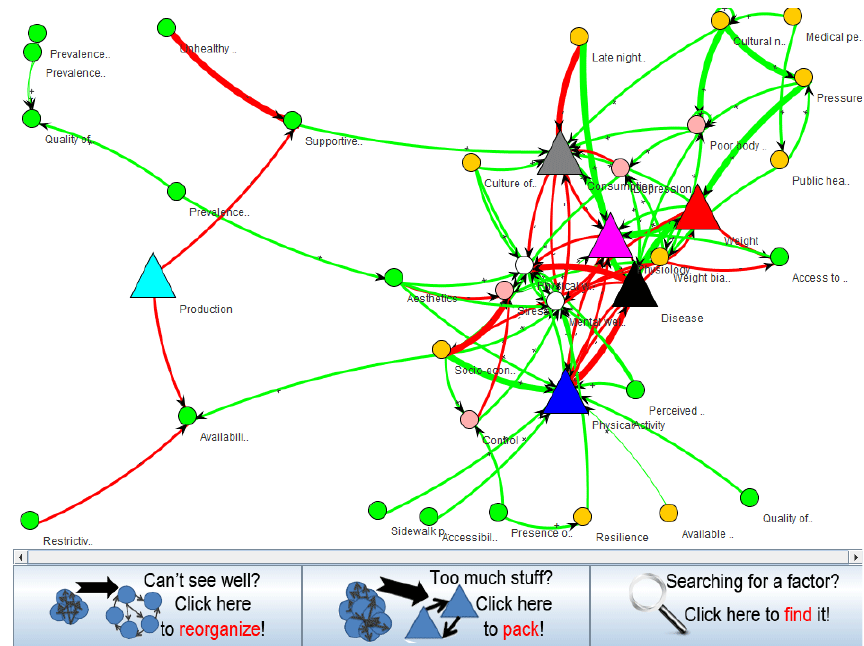
Figure 4. Exploring the causal map in the first Version of ActionableSystems . Policymakers can view relationships between high-level themes (triangles), or detail them to reveal individual factors (circles). Green lines indicate a causal increase while red lines indicate a causal decrease.